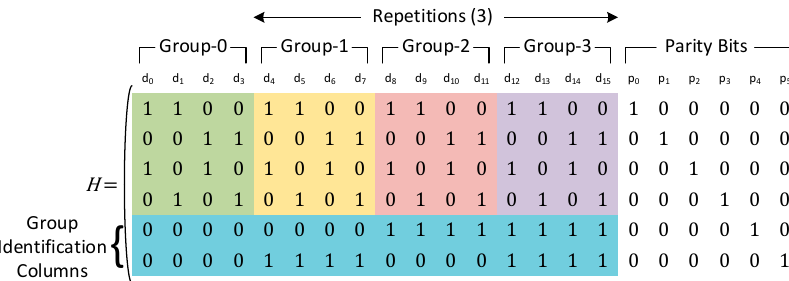
Figure 6. Parity check matrix of the proposed codes with four groups of four data bits each.